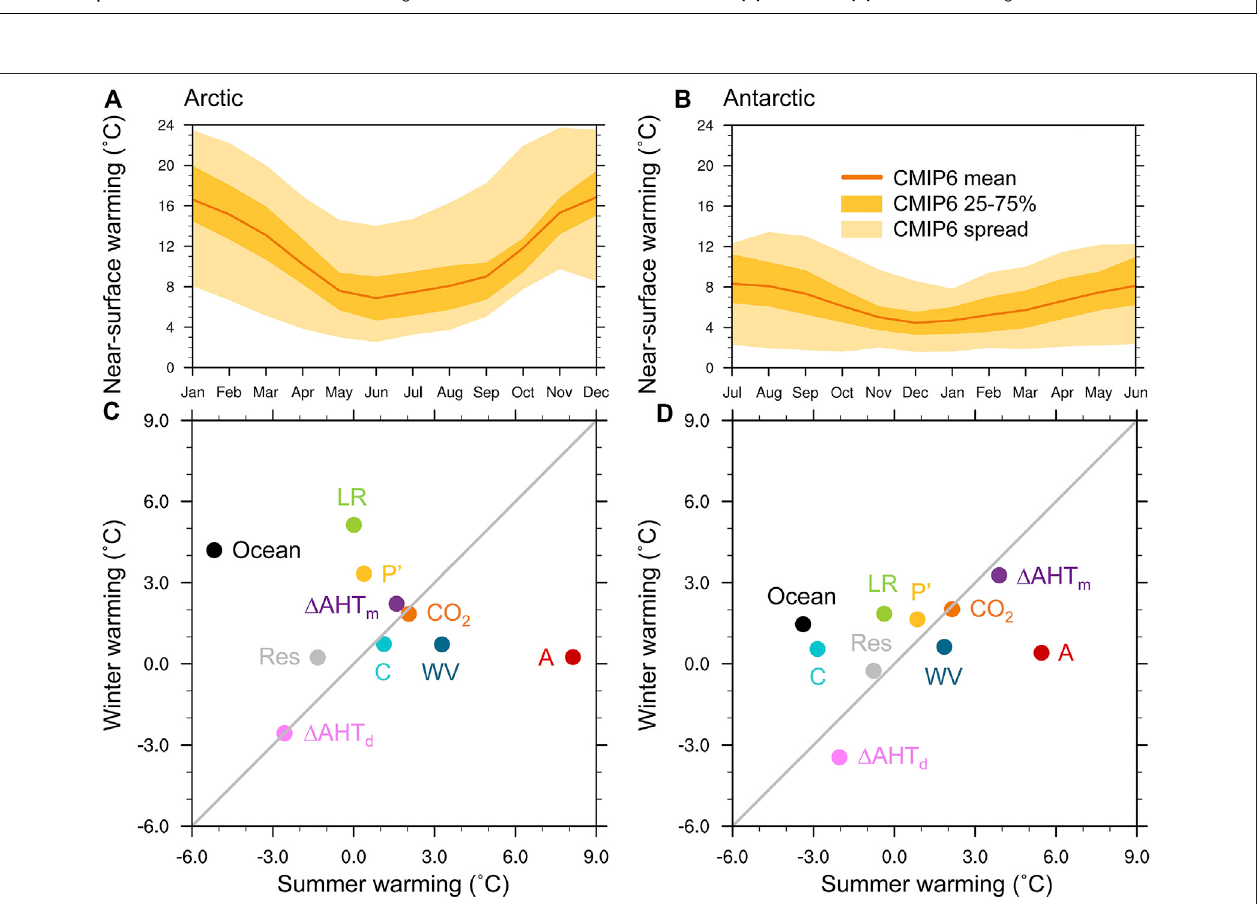
FIGURE8| Monthlynear-surfacewarming( ˚ C)centeredaroundyear-100ofabruptCO 2 quadruplingfortheCMIP6multimodelmean(orangeline),the25thto75th percentile (dark orange shading), and the full intermodel spread (light orange shading) in (A) the Arctic and (B) the Antarctic. (C,D) Contributions to winter and summer warming ( ˚ C) centered around year-100 ofabrupt CO 2 quadrupling inCMIP6 for (C) the Arctic and (D) the Antarctic. Warmingcontributionsare shown forthe lapse-rate (LR), surface albedo (A), water-vapor (WV), and cloud (C) feedbacks, the variation in the Planck response from its global-mean value (P ’ ), effective radiative forcing (CO 2 ), change in moist and dry AHT convergence ( Δ AHT m ; Δ AHT d ) and ocean heat uptake (Ocean), and residual term (Res).